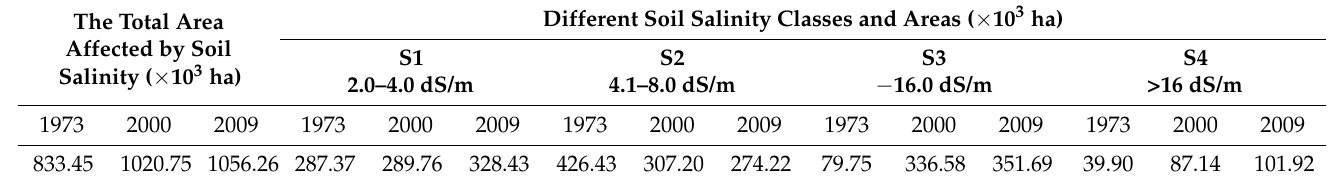
Table 1. Soil salinity-affected areas in the coastal region between 1973 and 2009